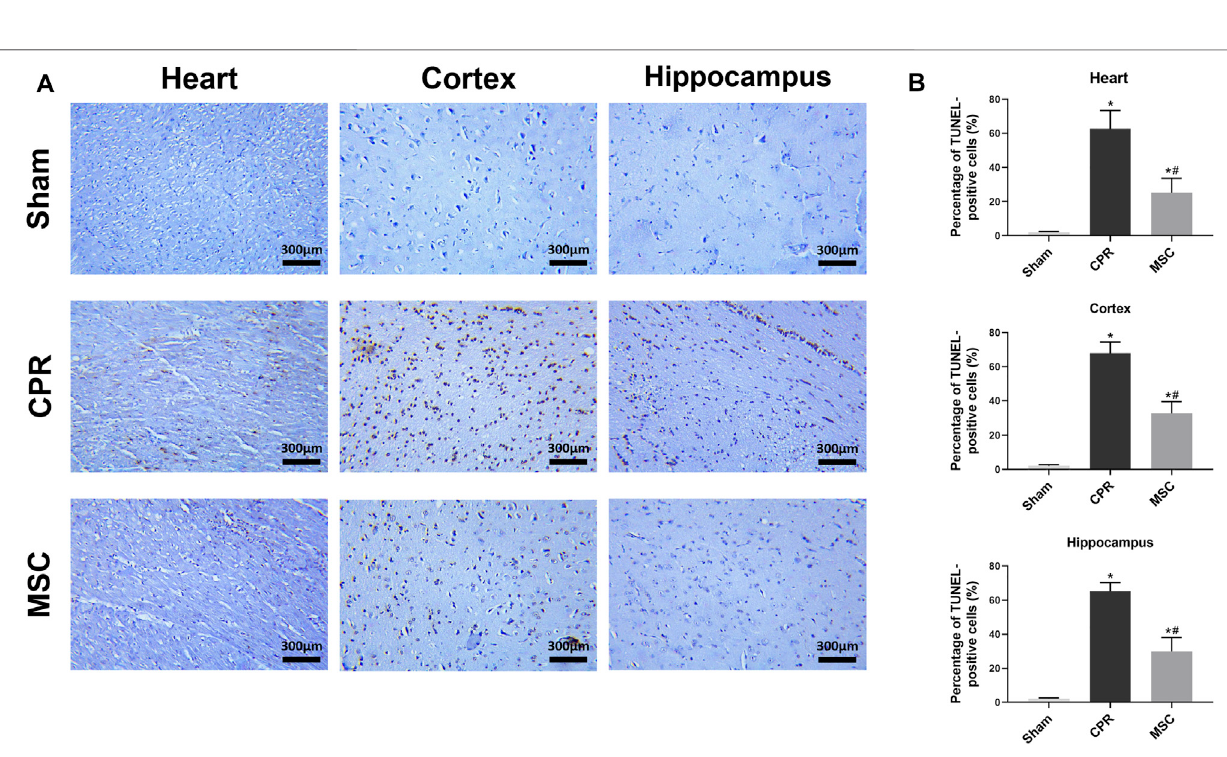
FIGURE5| Cellapoptosisintheheart,cortexandhippocampus (A) RepresentativephotomicrographsofTUNELassay( × 200magni fi cation) (B) Thepercentageof TUNEL-positivecells.TUNEL,TdT-mediateddUTPnickendlabelling;CPR,cardiopulmonaryresuscitation;MSC,mesenchymalstemcell.* p < 0.05versusshamgroup; # p < 0.05 versus CPR